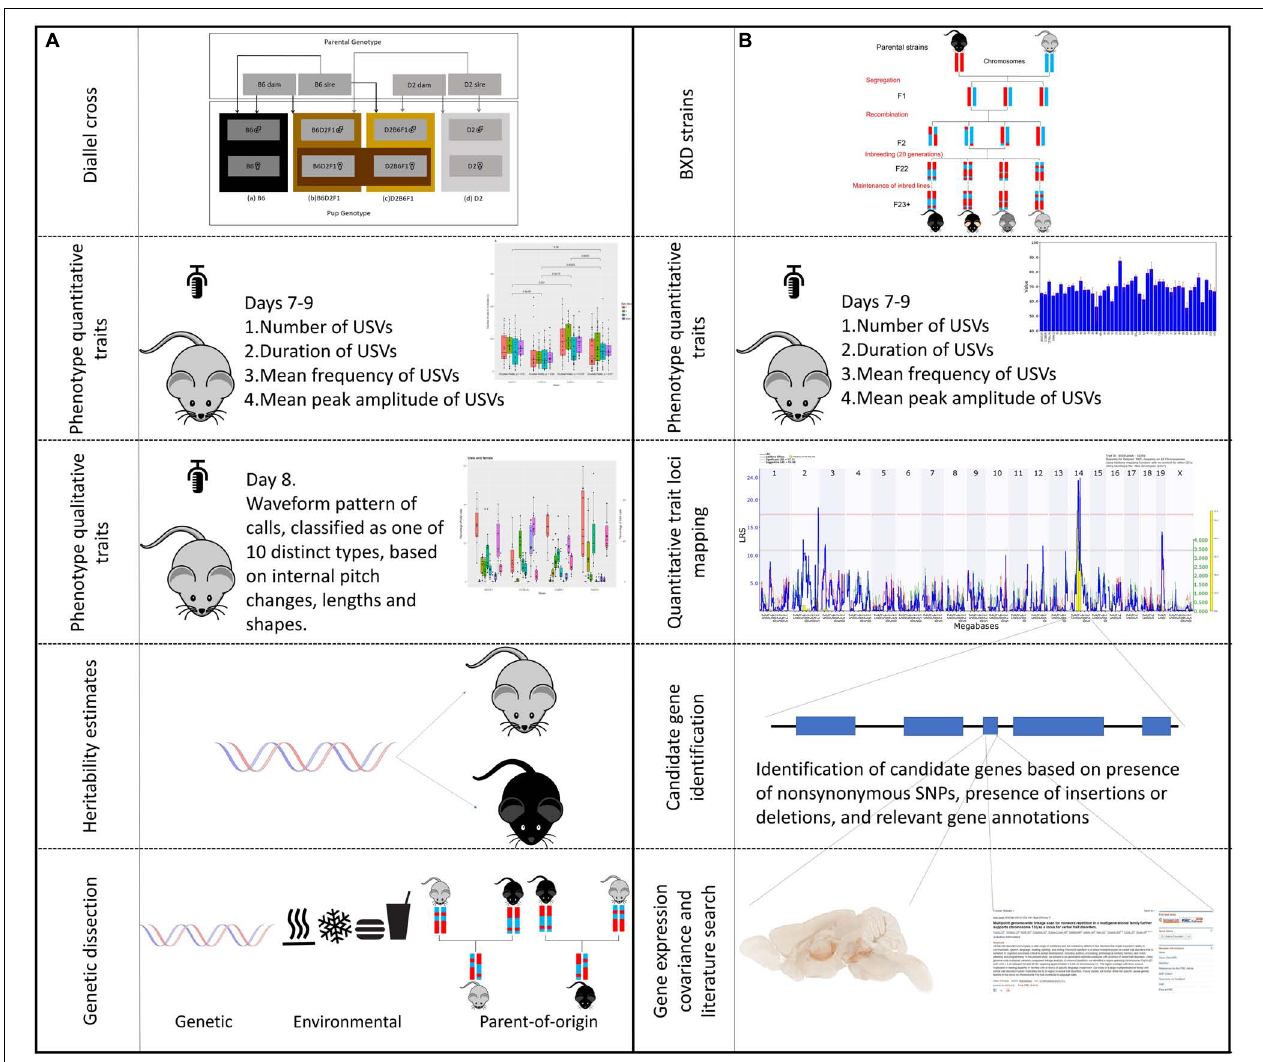
FIGURE 1 | Outline of experimental design. The study is separated into two, complementary, parts, one using the BXD family for trait mapping, and the other using the parental diallel cross to study heritability and qualitative traits. The workflow of different aspects of the experiments are shown. (A) BXD strains were derived by crossing C57BL/6J (B6) and DBA/2J (D2) parents. The resulting heterozygous F1 mice were crossed to produce non-reproduceable F2 offspring representing recombinations of the parental B6 and D2 genomes. These F2 offspring were then inbred by sib-mating for 20 generations, at which point each strain represents